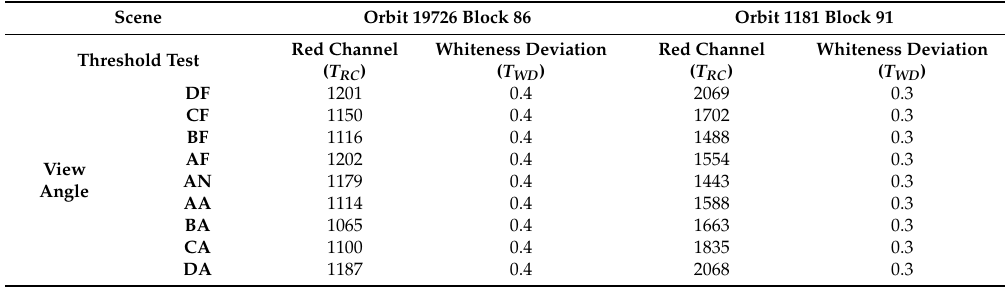
Table 1. Threshold values used in the custom cloud masks for the selected